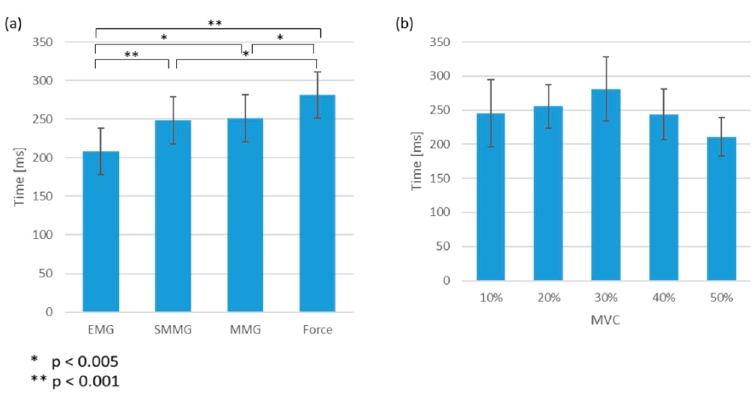
Figure 4. ( a ) Time of onset in EMG, SMMG, MMG and force signals from the audio instruction. Error bar showing standard error. ( b ) Time of onset of measured with SMMG at 10%, 20%, 30%, 40% and 50% MVC levels from the audio instruction. Error bar showing standard error.